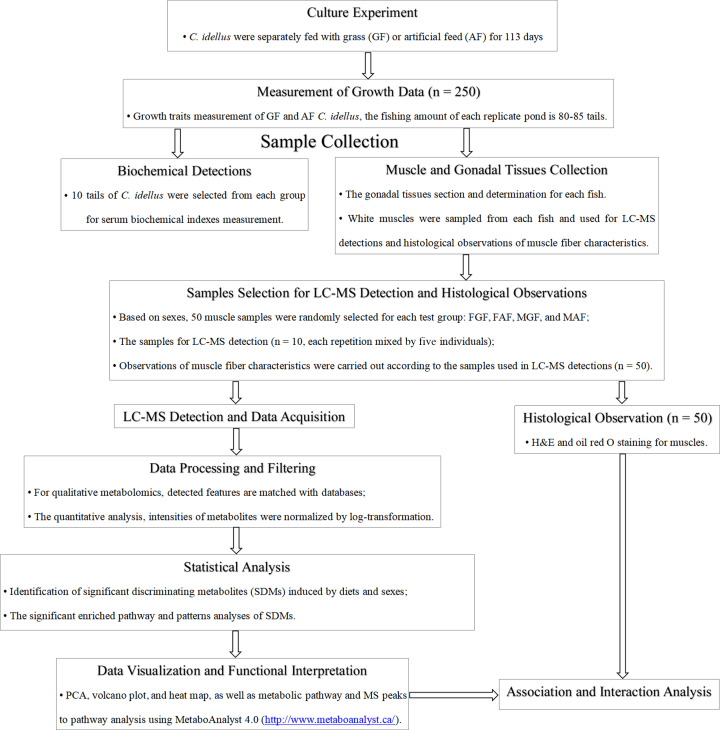
The experimental design and flowchart. H&E: hematoxylin & eosin; PCA: principle component analysis.